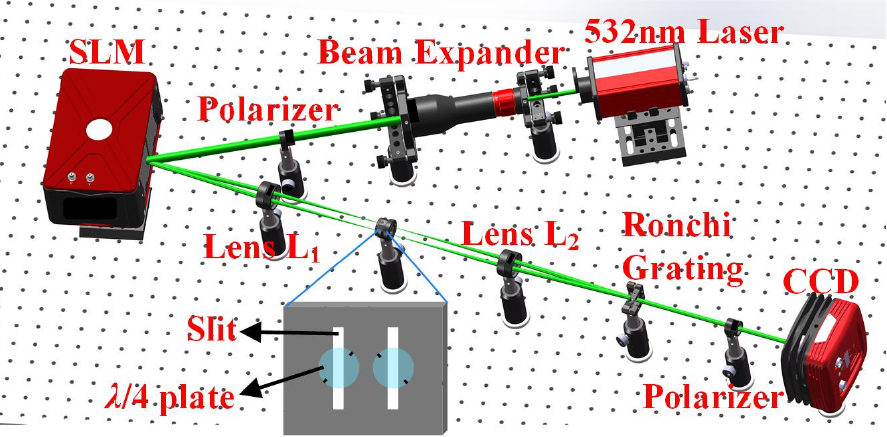
Figure 2. Schematic of experimental setup composed of an SLM and a 4- f system for generating vector beams. Firstly, a 532 nm collimated laser beam, passing through a linear polarizer in the x direc- tion, illuminates a reflective liquid crystal SLM which is equipped with 1920 × 1080 pixels (each pixel has an 8 µ m × 8 µ m size). Here the diameter of the collimated laser beam has been enlarged by the beam expander to match the panel window size of the SLM. In the 4- f system, composed of a pair of identical lenses (L 1 and L 2 ) with the same focal length of f , SLM and Ronchi phase grating are placed at the front focal plane of L 1 and the rear focal plane of L 2 , respectively. The rear focal plane of L 1 and the front focal plane of L 2 overlap at the middle plane of the 4- f system, which is known as the Fourier plane of the 4- f system. Secondly, the incident linearly polarized beam is diffracted into various diffraction orders by a predetermined holographic grating (HG) displayed at the SLM. A spatial filter with two separate slits is placed at the Fourier plane to only let the